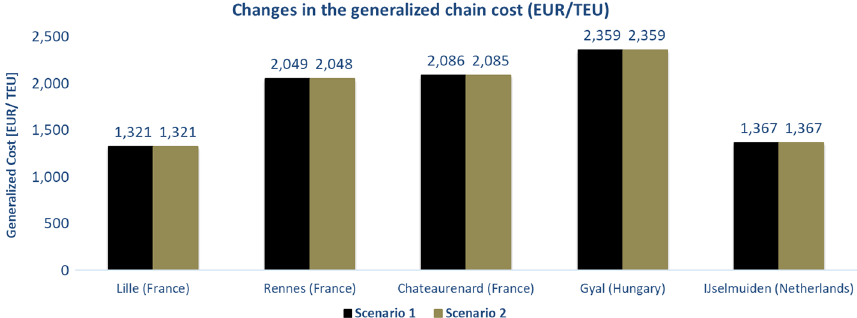
Fig. 9 Changes in supply chain costs between scenarios 1 and